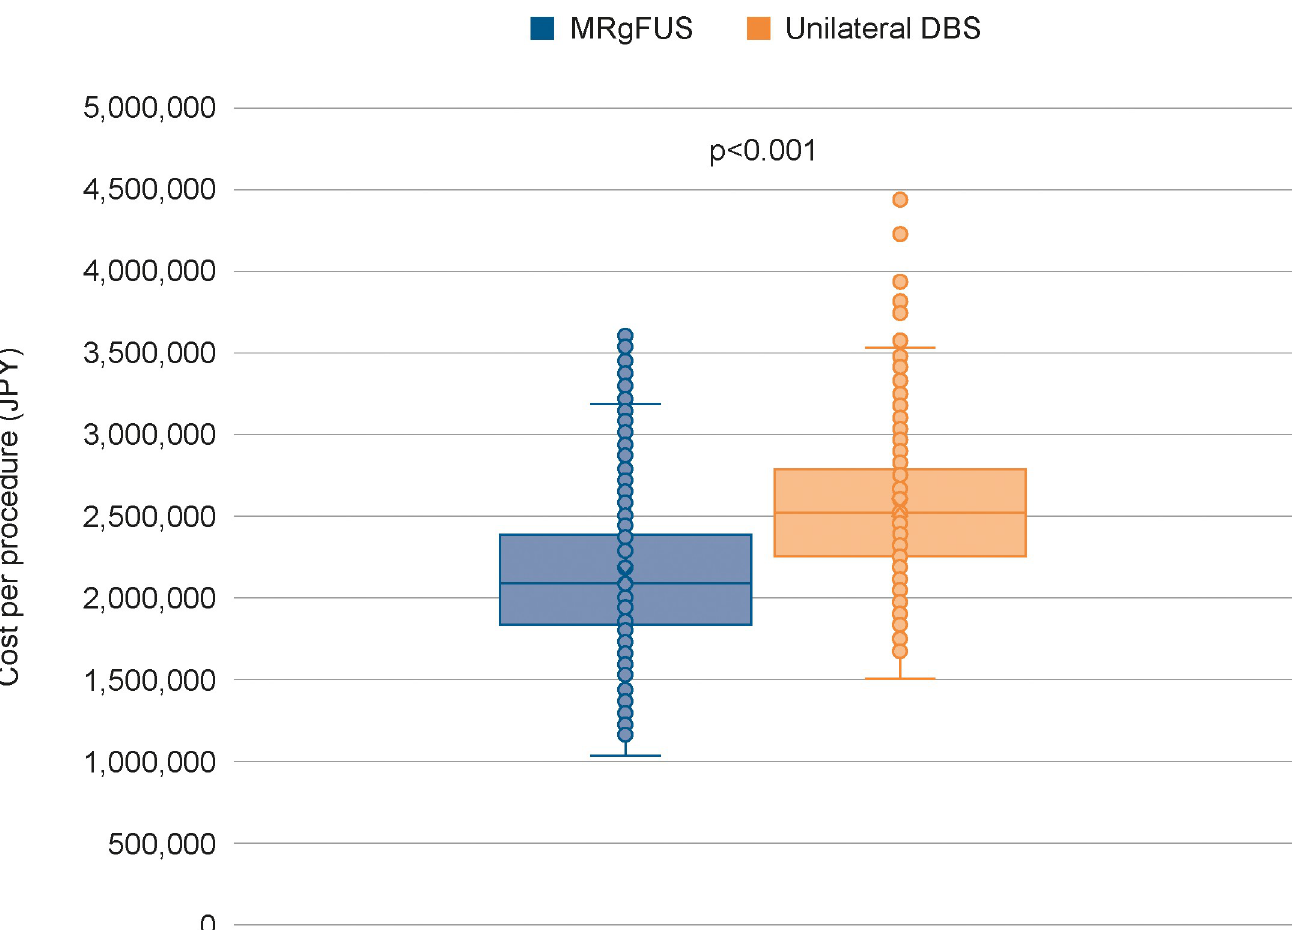
Fig 1. Results of PSA. Box and whisker plot presenting median per procedure costs for MRgFUS and unilateral DBS. The boxes represent the 1 st and 3 rd quartiles (interquartile range); lower error bars indicate up to 1.5 times the interquartile range below the first quartile, and upper error bars indicate up to 1.5 times the interquartile range above the third